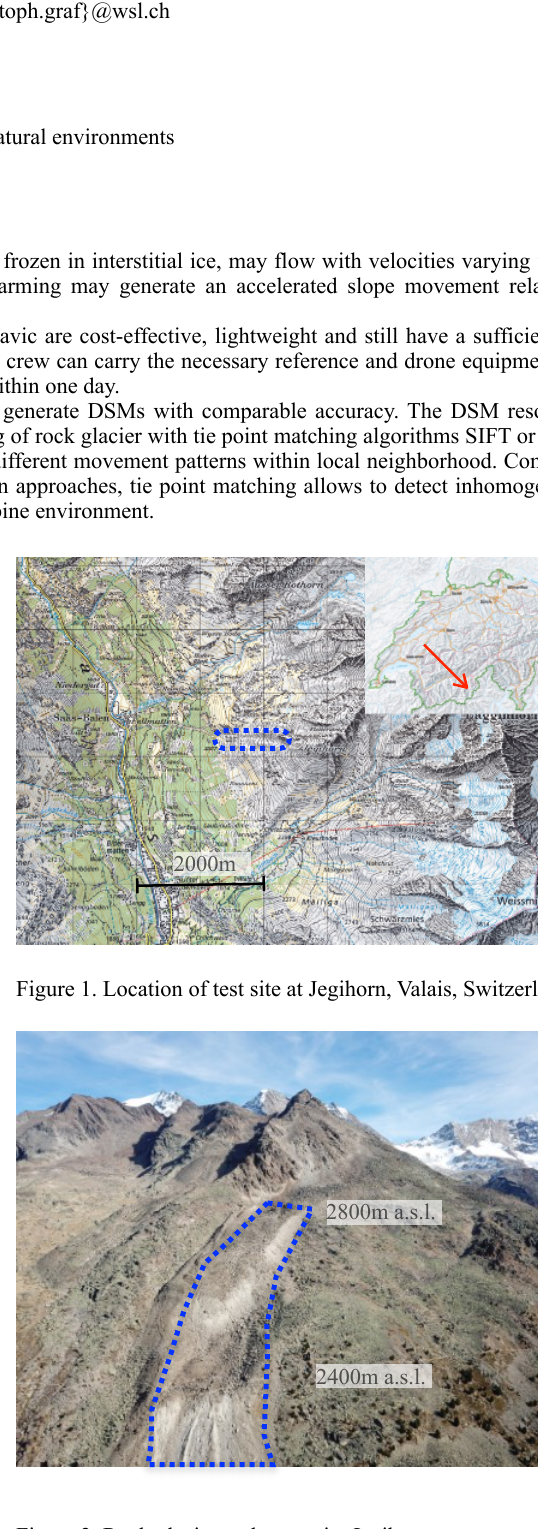
Figure 2. Rock glacier at the test site Jegihorn.